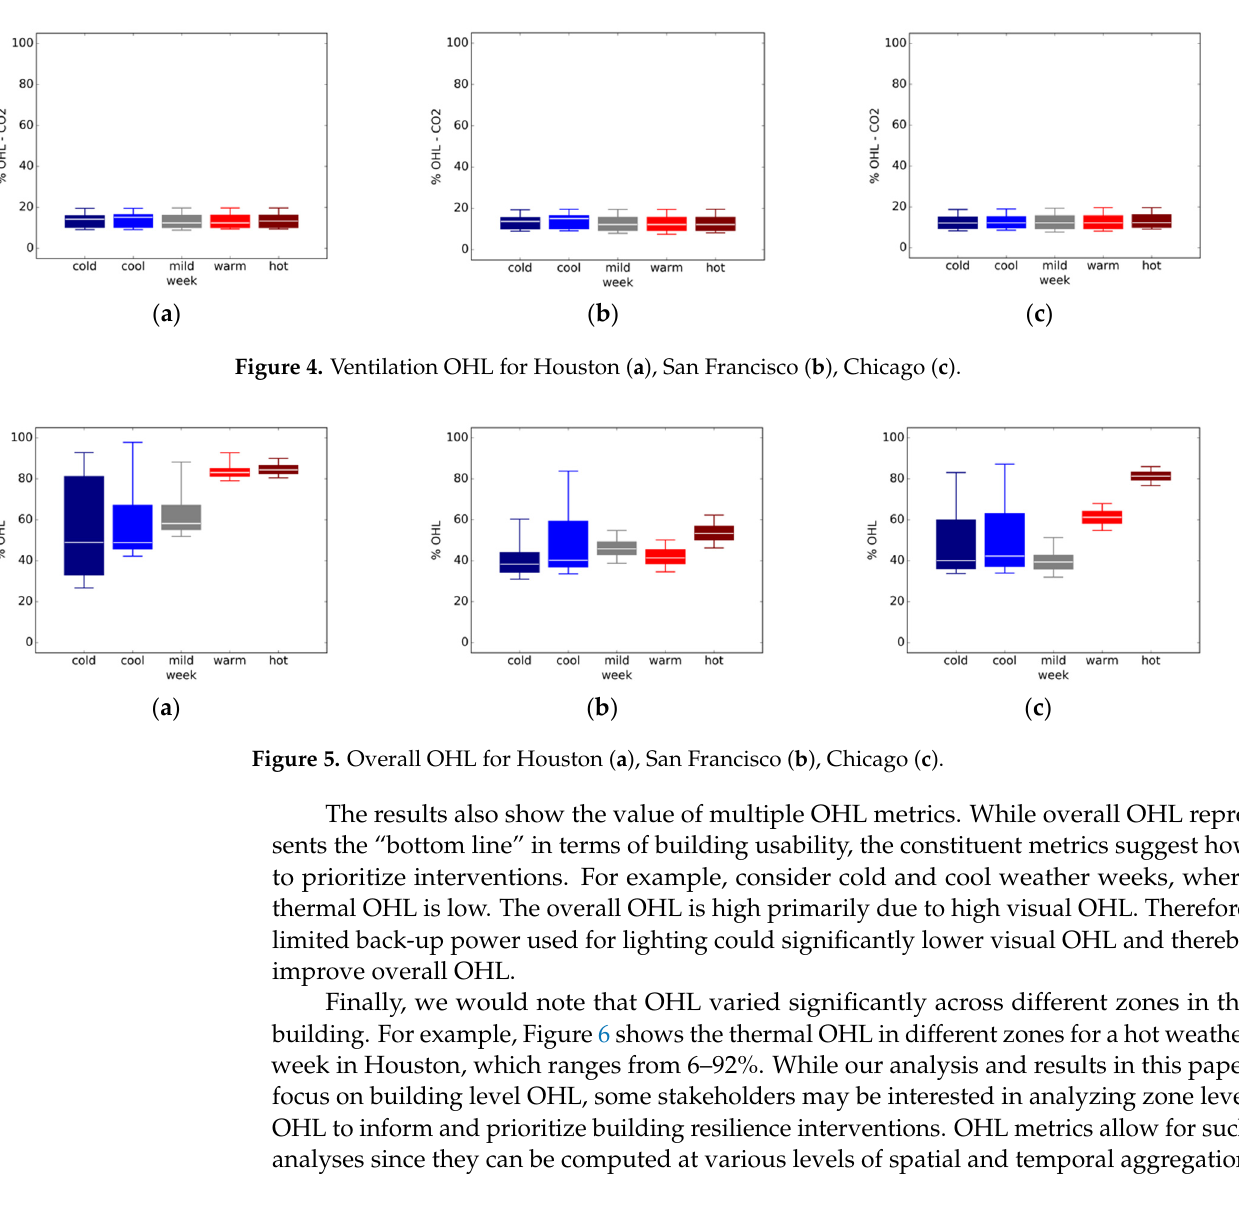
Figure 3. Visual OHL for Houston ( a ), San Francisco ( b ), Chicago ( c ).